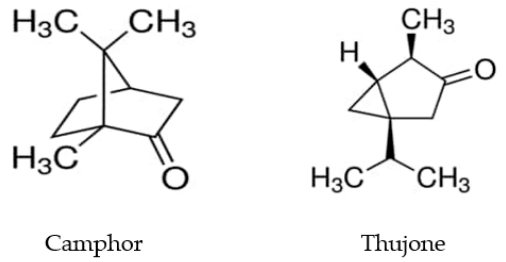
Figure 3. Structural formulae of camphor and